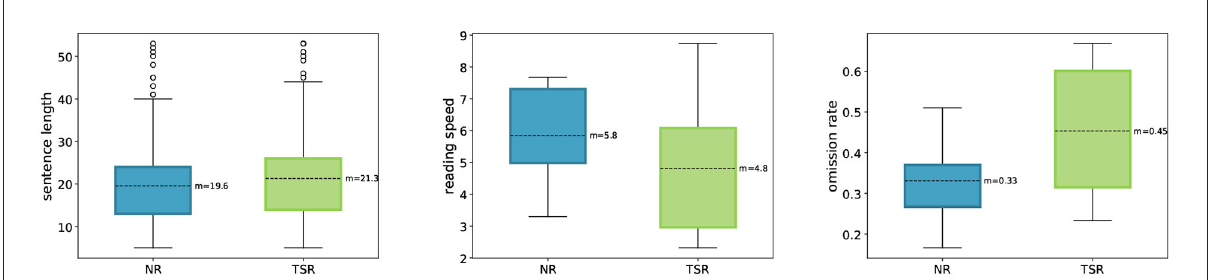
FIGURE1 Sentence length (words per sentence), reading speed (seconds per sentence) and omission rate (percentage of words not fixated) comparison between normal reading (NR) and task-specific reading (TSR) of the sentence in ZuCo 2.0.